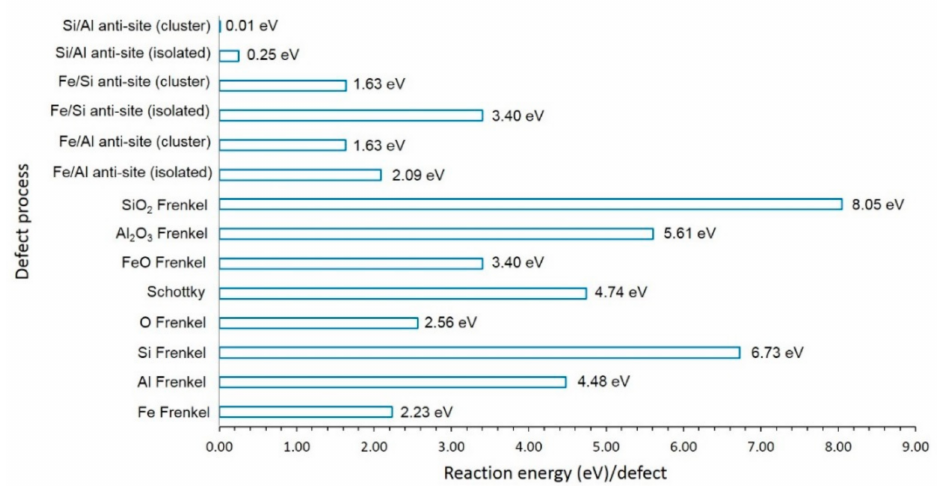
Figure 2. Energies of intrinsic defect